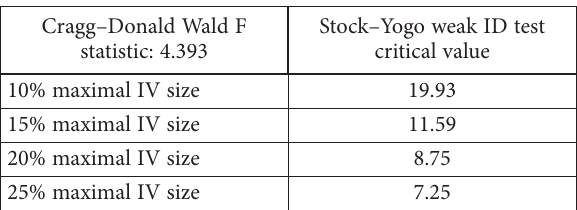
Table 3. Weak instrumental variables test Cragg–Donald Wald F statistic: